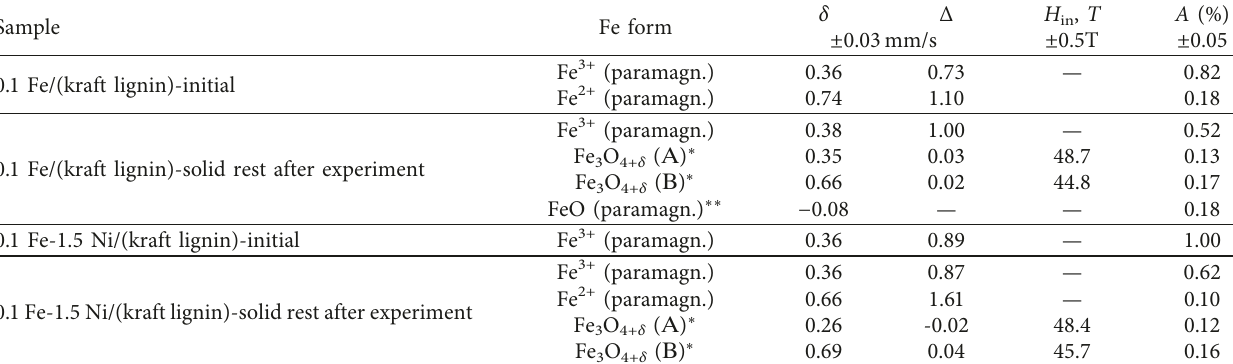
Table 3: M¨ossbauer parameters of the spectra at T � 300K of samples 0.1 Fe/(kraft lignin) and 0.1 Fe–1.5 Ni/(kraft lignin) before and after the